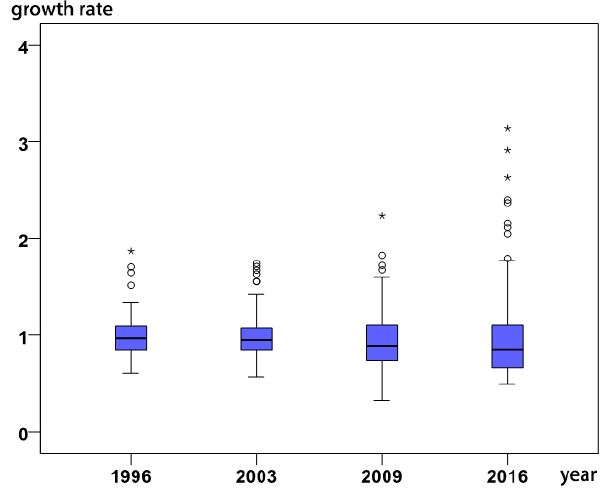
Figure 7. Box-plot of STCP from 1996 to 2016.